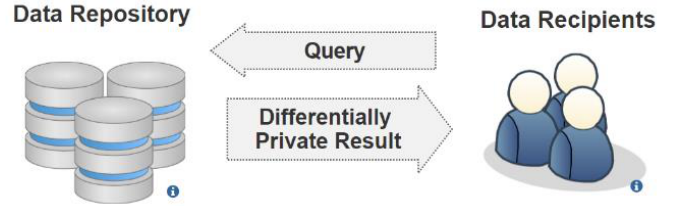
Fig. 3. Differential privacy